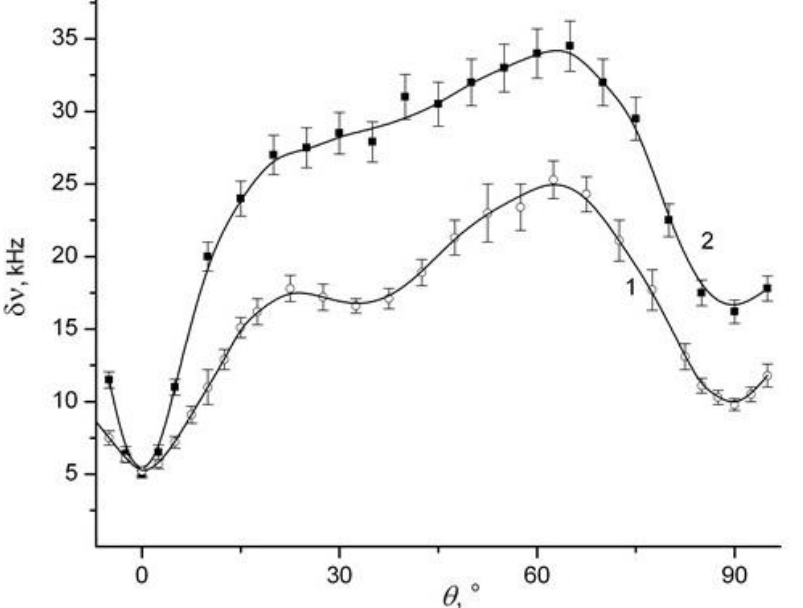
Figure 9. Angular dependence of the line width of the central transition of the 93 Nb NMR spectrum in samples (1) NSLN2 and (2) CLN3.